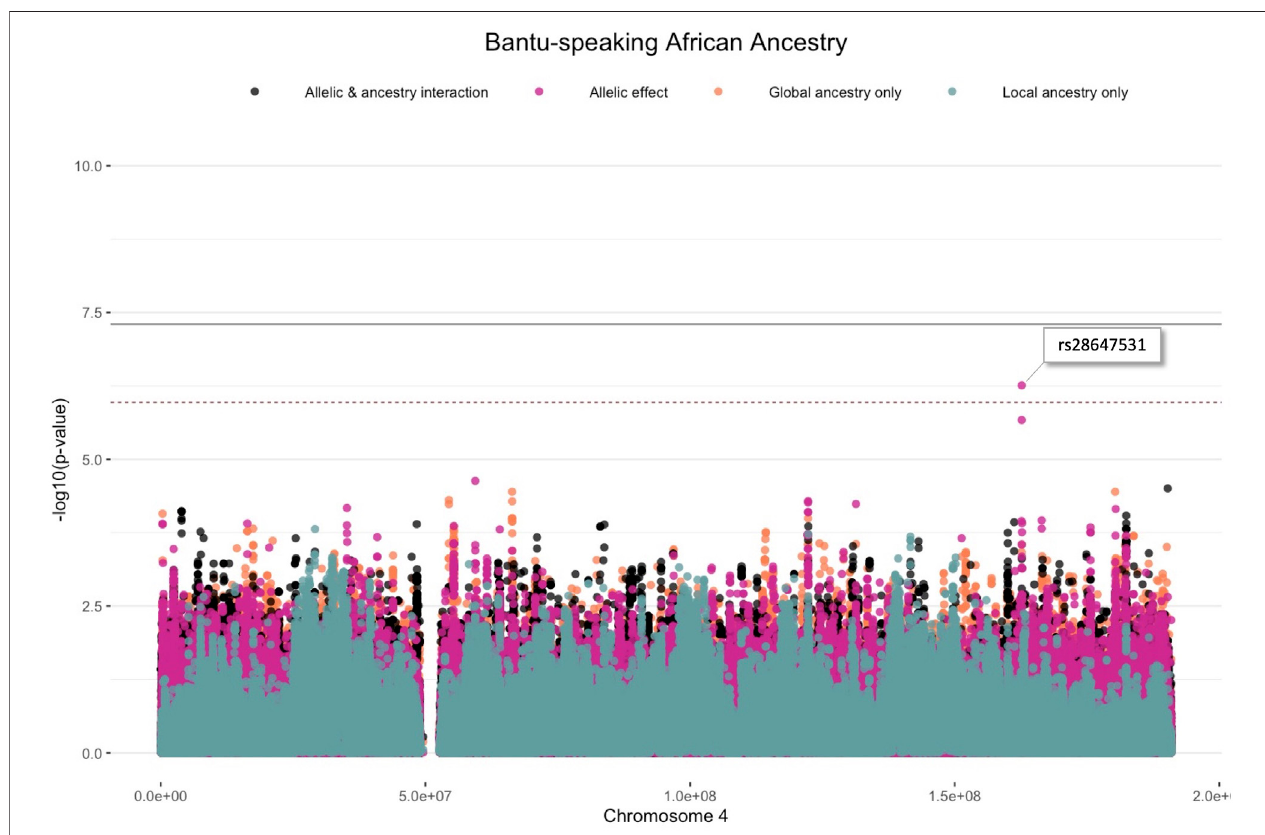
FIGURE 3 | Log transformation of association signals ( p -value < 1.078 × 10 − 6 ) obtained for Bantu-speaking African ancestry whilst using the allelic model whilst adjusting for local ancestry on chromosome 4. The dashed red line represents the signi fi cant threshold for admixture mapping calculated with the software STEAM and the black solid line represents the genome-wide signi fi cant threshold of 5 × 10 − 8 . The four different models are represented in orange (global ancestry only), blue (local ancestry effect), pink (minor allelic effect only) and black (both minor allelic and ancestry effects).